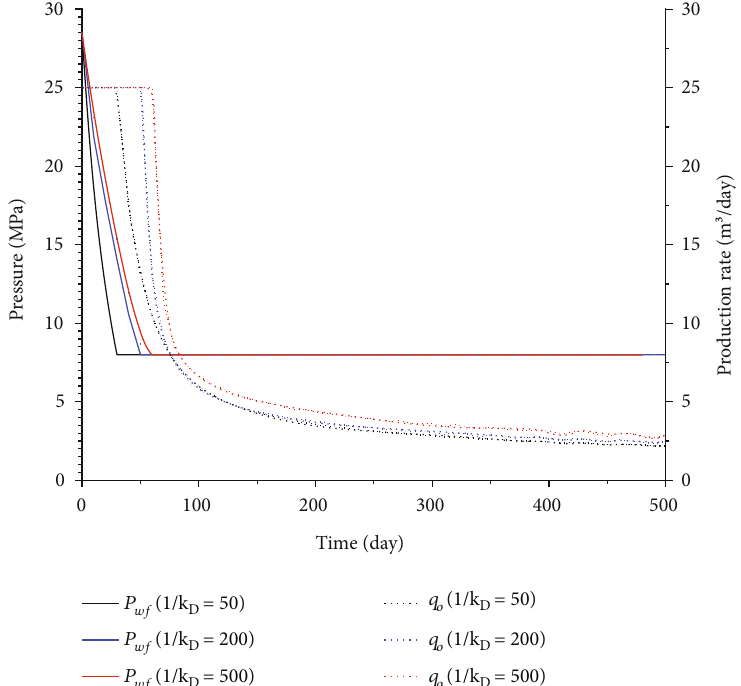
Figure 15: The e ff ect of mobility ratio on well performance (compound working